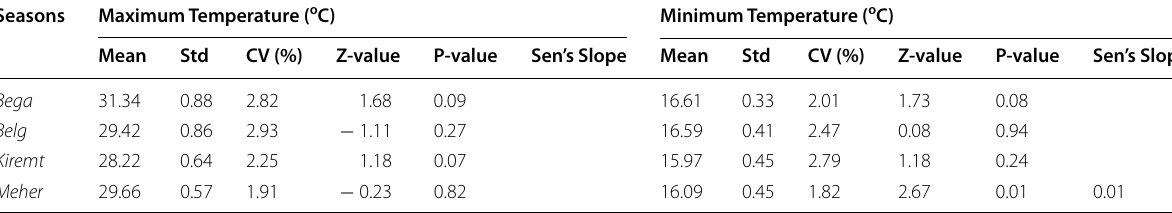
Table 4 Descriptive statistics and test results seasonal Tmax and Tmin (1981–2018) Seasons Maximum Temperature ( o C) Minimum Temperature ( o